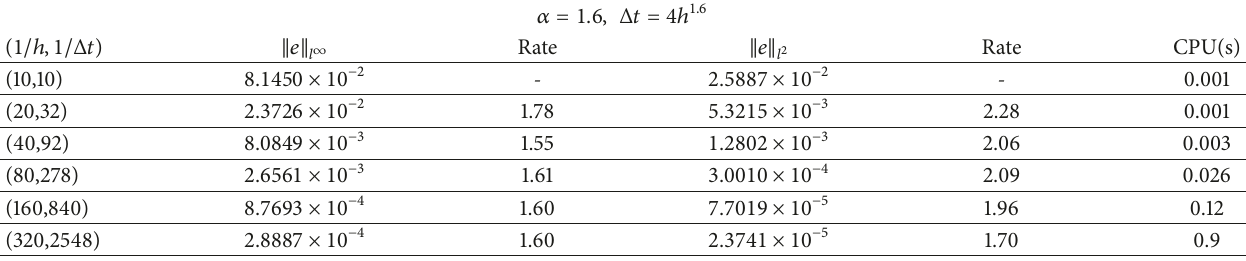
Table 1: Error and convergence rates for Example 1. 𝛼 = 1.6, Δ𝑡 = 4ℎ 1.6